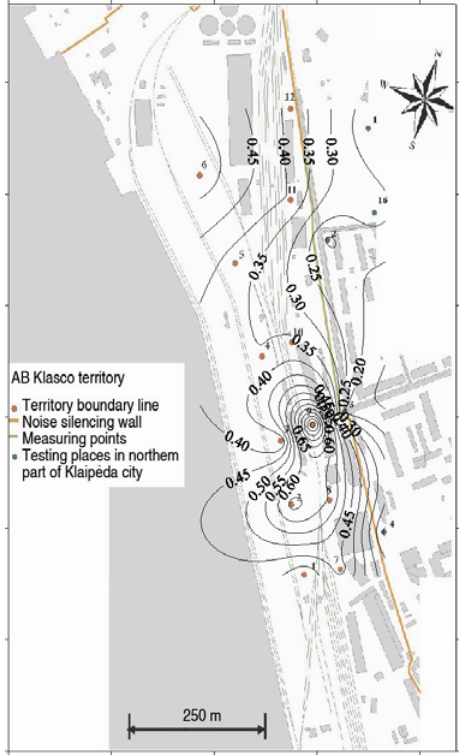
Fig 3 . Dustiness in the daytime in